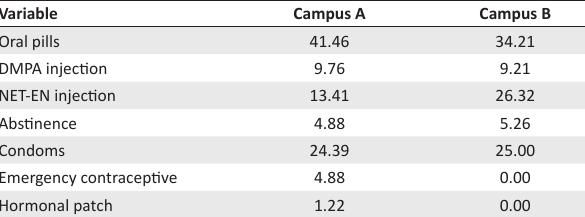
TABLE 5: Percentage of method of contraceptive used.